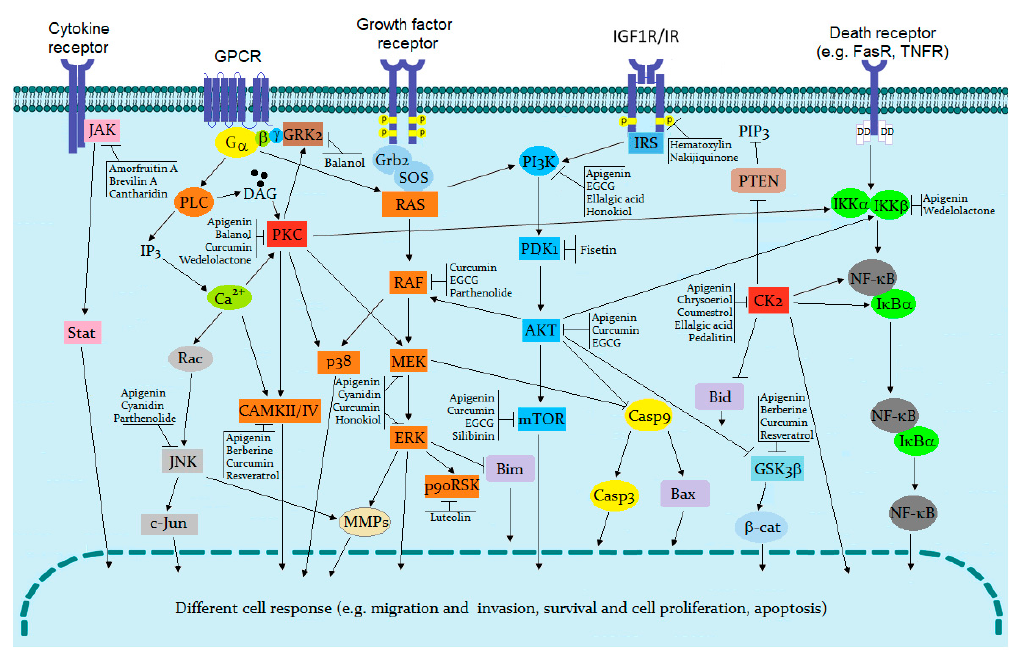
Figure 1. Schematic presentation of intracellular transduction pathways, including protein kinases and examples of their inhibition by natural compounds.